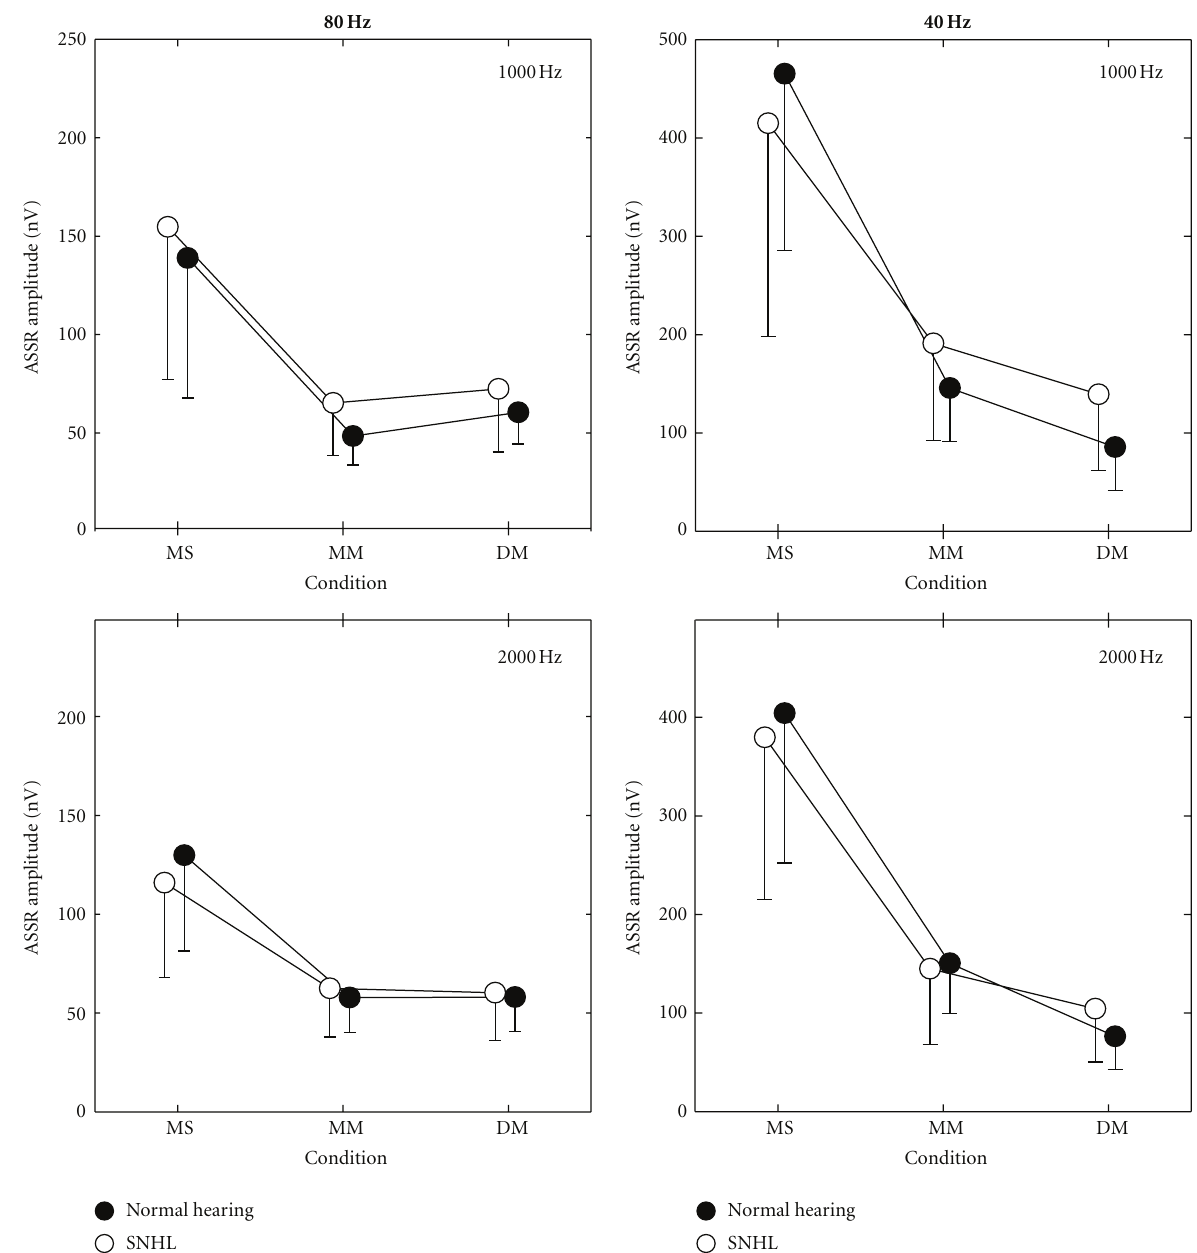
Figure 3: Mean (and SD) ASSR response amplitudes for both groups for the MS, MM, and DM conditions at the 40 and 80 Hz rates. similar percent decreases in the MM condition relative to the MS condition (rate × condition interaction: P < .